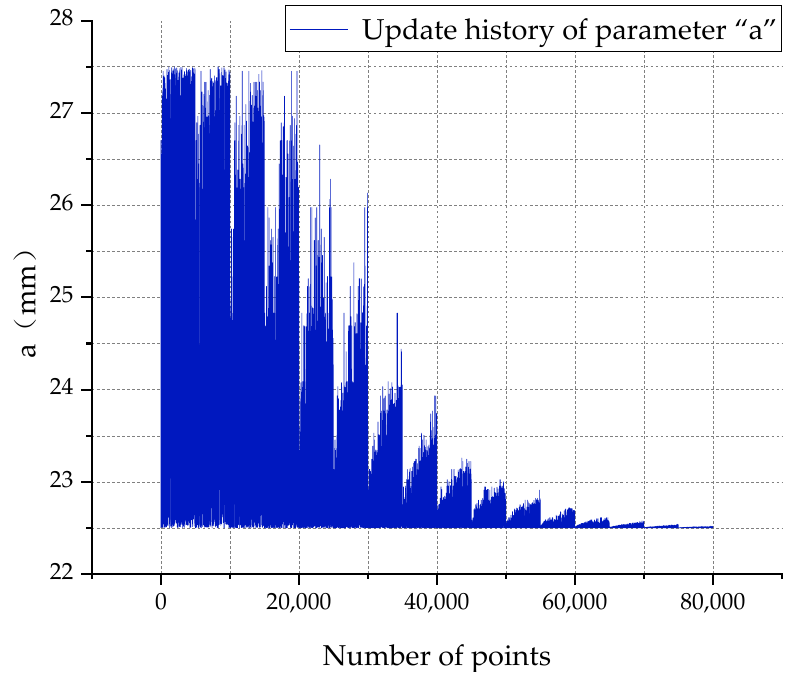
Figure 20. The iterative process of parameter “a”.